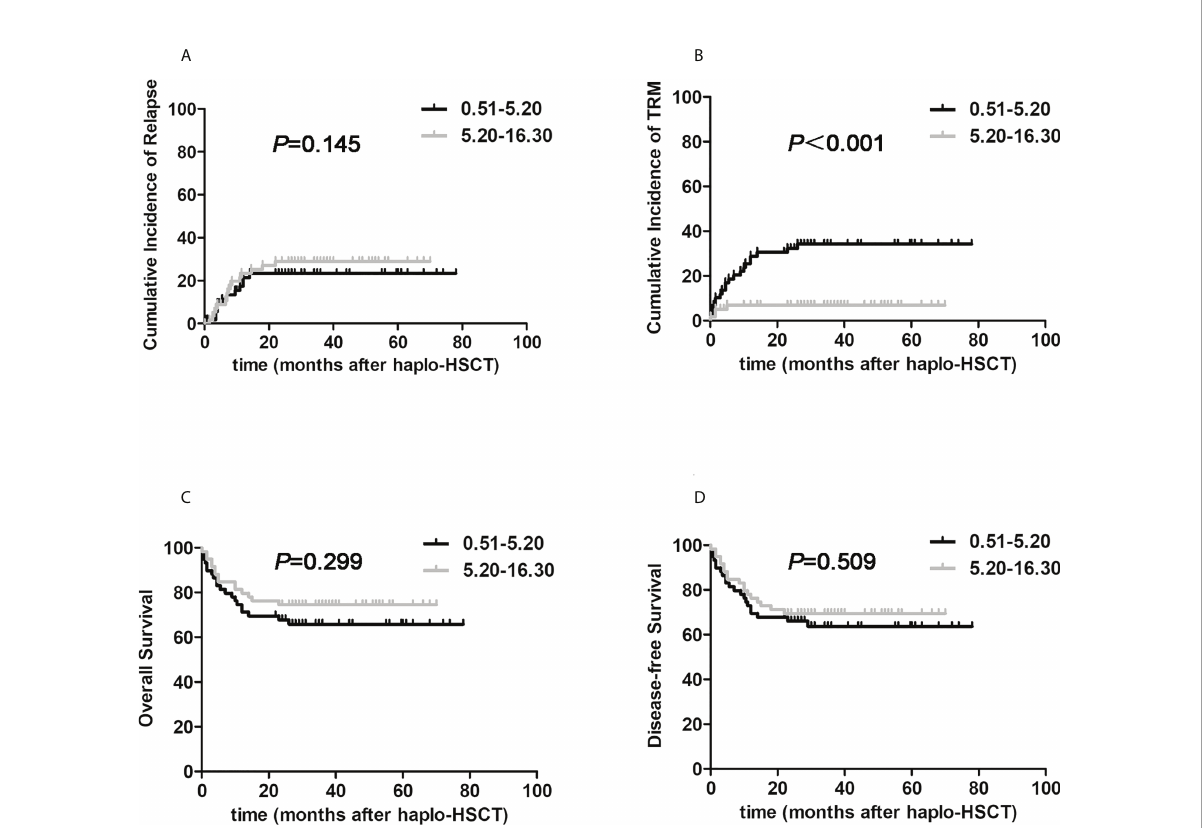
FIGURE 3 The impacts of nucleated cells from G-CSF-primed BM harvests on post-transplant outcomes in halpo-HSCT using G-CSF-primed BM and PBSCs mixture. The G-CSF-mobilized BM and PBSCs cohort was classi fi ed into two groups according to infused nucleated cells harvested from G-CSF-primed BM: 0.51-5.20×10 8 /kg (the black line, n=62), 5.20-16.30×10 8 /kg (the gray line, n=63). (A) relapse; (B) TRM; (C) Overall survival; (D) Disease-free